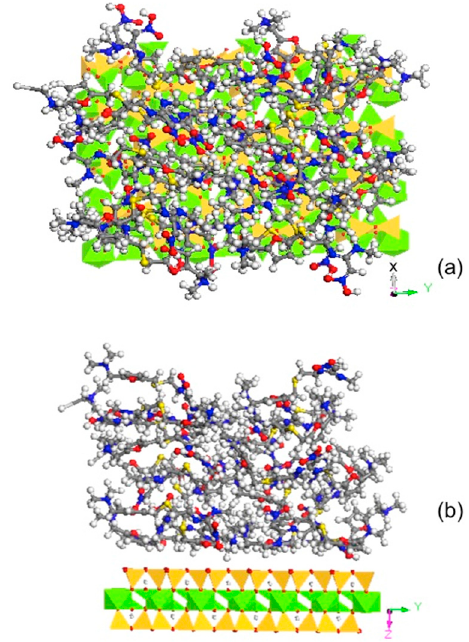
Figure 6. Molecular dynamic simulation showing the multilayer surface configuration of sorbed RT on talc along ( a ) [001] and ( b ) [100] directions.